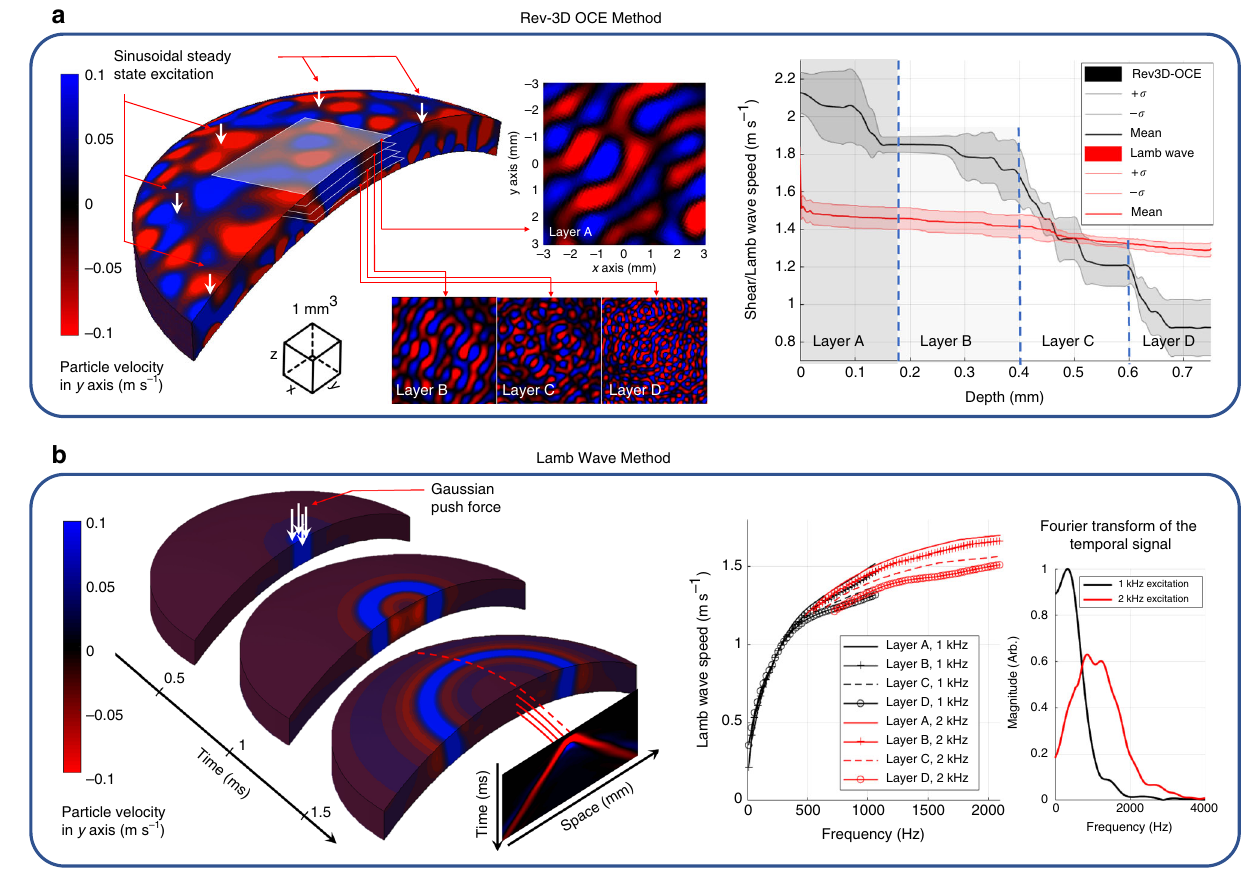
Fig. 2 Comparative analysis of Rev3D-OCE and the Lamb wave method using numerical simulations. Numerical simulation results of a 3D fi nite element model of cornea composed of four layers with differentiated linear elastic materials distributed monotonically from stiffer to softer: A, B, C, and D, corresponding to 2.5, 2, 1.3, and 0.8 m s − 1 of shear wave speed. a Cornea model subjected to sinusoidal steady-state excitation of 2 kHz (Rev3D-OCE method) through eight circular-distributed force heads. Reverberant patterns extracted in each layer depict differentiated wavelength and are transformed into shear wave speed values using Eqs. (1) – (3) as plotted in the shear/Lamb speed vs. depth diagram. b Cornea model subjected to axisymmetric Gaussian ( σ = 0.3 mm) transient ( t = 1 ms) force (Lamb wave method) producing a cylindrically-shaped Lamb wave propagation. Dispersion curves (Lamb speed vs. frequency) are calculated for each layer. Dispersion curves produced from a transient ( t = 0.5 ms, σ = 0.3 mm) force are also included. The Fourier transform of both temporal excitations ( t = 0.5 ms, and t = 1 ms) measured in the model are also shown. Given a selected frequency (1 kHz), depth- dependent Lamb wave speed pro fi le is plotted in the shear/Lamb speed vs. depth diagram of ( a ) for further